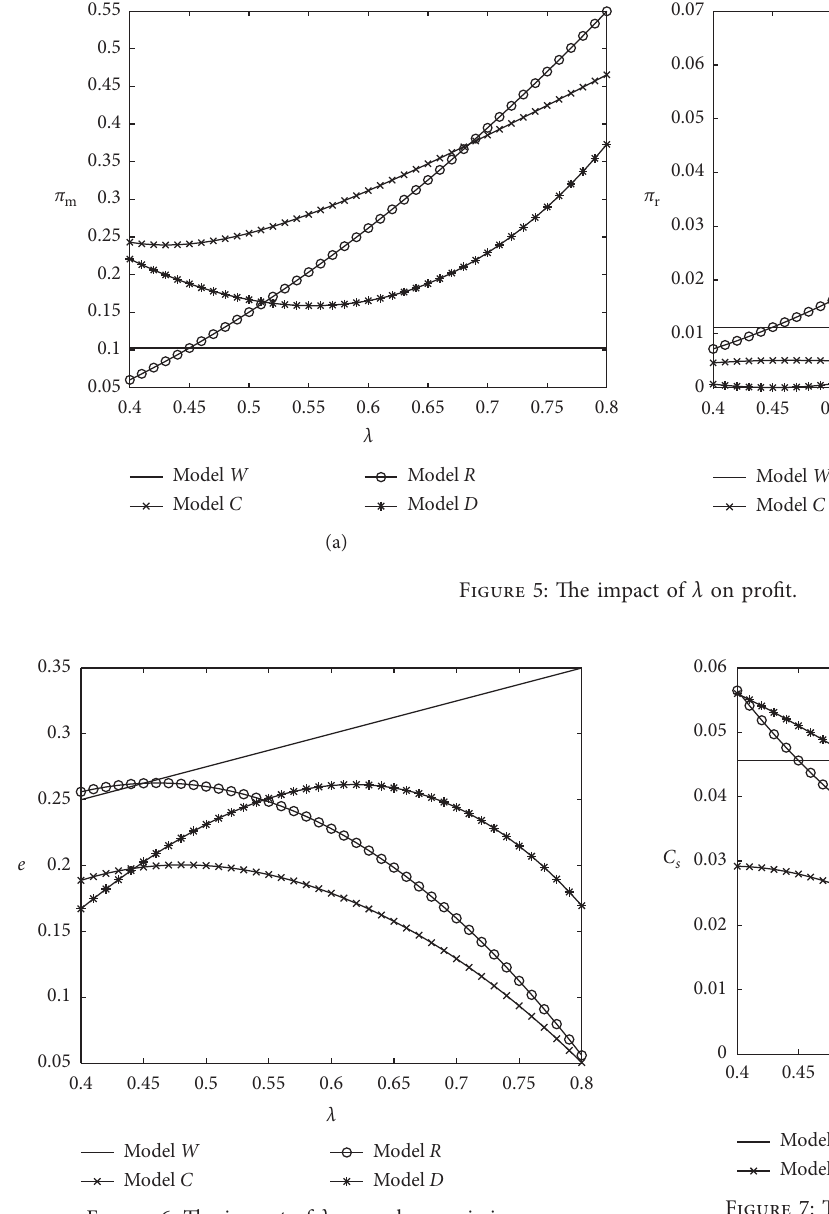
Figure 6: The impact of λ on carbon emission.